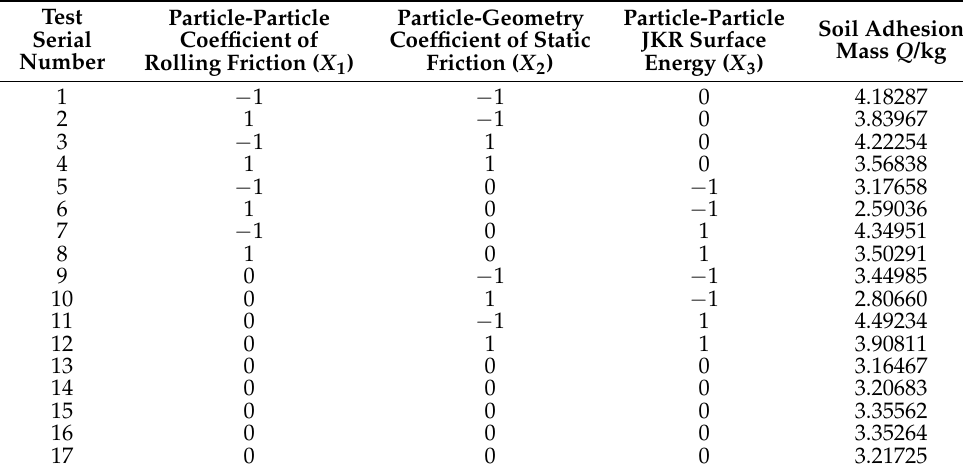
Table 5. Results of Box-Behnken Design test